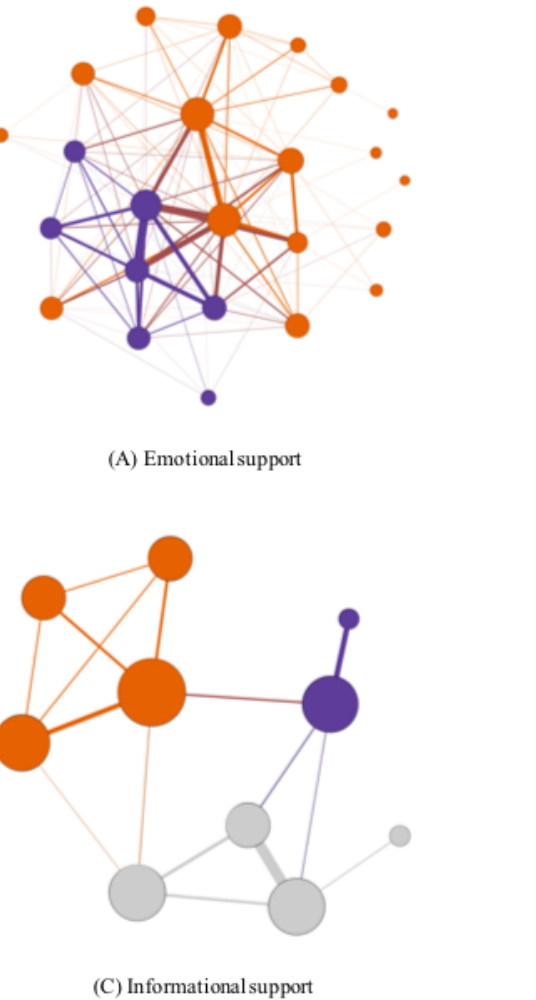
Figure 2. Network structures of Second Life Impacts Diabetes Education & Self-Management (SLIDES) social support interactions by the type of support. Node size indicates degree and node color indicates the existence of subcommunities, where larger subcommunities are shown in orange and smaller subcommunities are shown in purple and